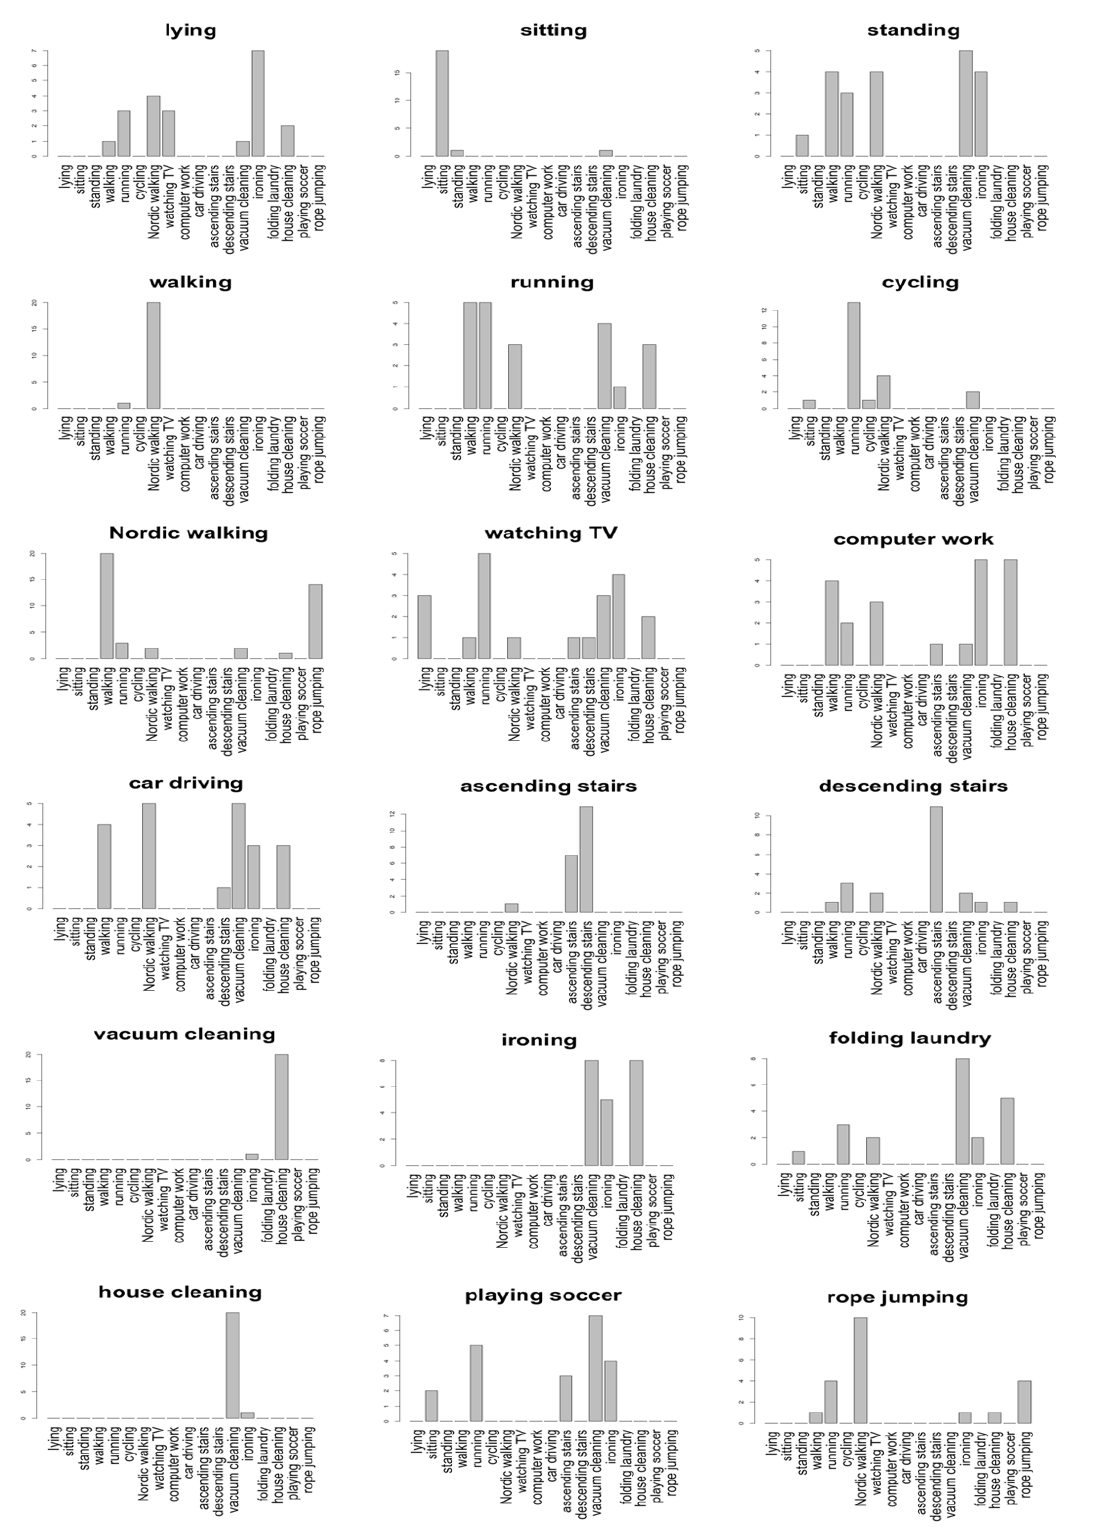
Figure A1. Result of the histogram of the nearest classes appearing in PAMAP2 data for each samples set for the word embedding area